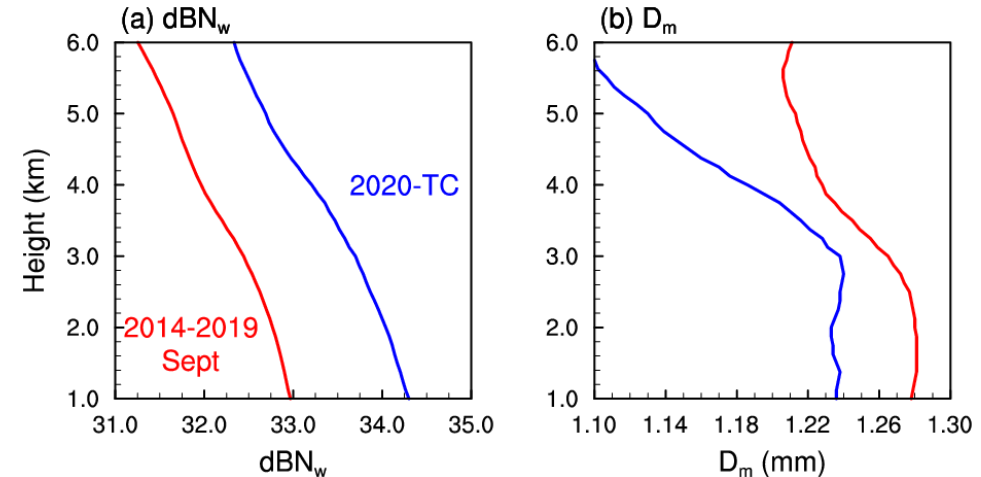
Figure 6. Vertical profiles for ( a ) dBN w and ( b ) D m . The blue line represents the 2020-TC period, and the red line represents the September 2014 – September 2019 period.